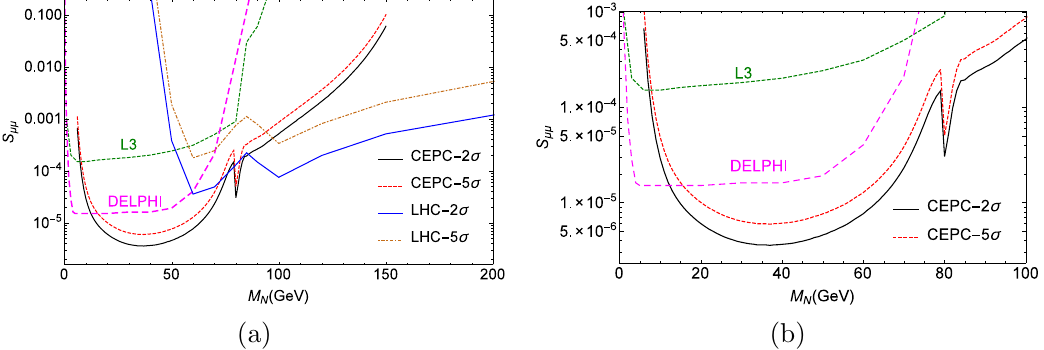
Figure 7 . Sensitivity on S (cid:22)(cid:22) at the CEPC. (b) is an enlarged version of (a) in the range of 0{ 100 GeV. For comparison, the 95% bound from the L3 [75] and DELPHI [76] searches and simulated LHC results in [37] are